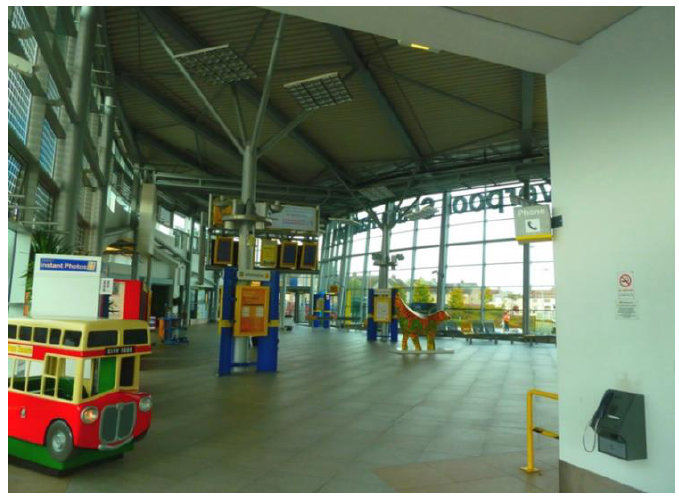
Figure 7. Example of train and bus stations promoting respect and social inclusion (P1) (South Parkway Railway Station, Liverpool).